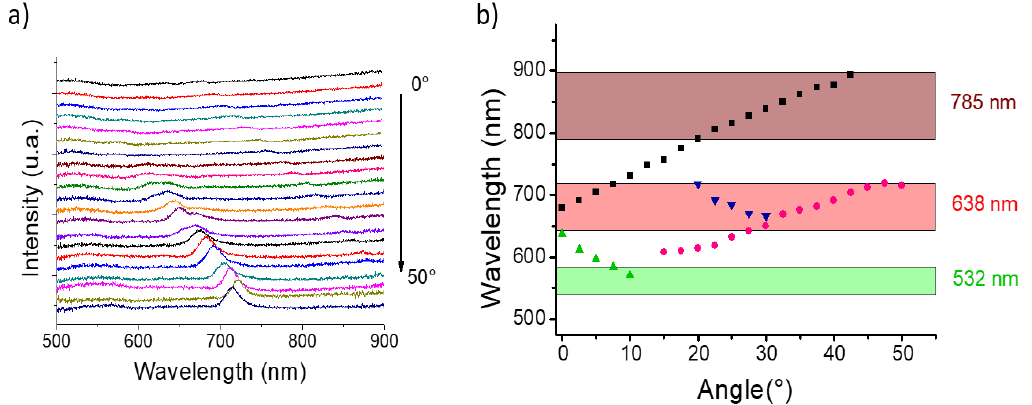
Figure 7. ( a ) Extinction spectra for our plasmonic substrate (nanocylinder diameter: 140 nm and thickness: 30 nm) depending on the incident angle (from 0 to 50 ◦ , step of 2.5 ◦ ). ( b ) Evolution of the position of the di ff erent plasmon bands depending on the incident angle (each symbol corresponds to the position of one band on the spectra shown in (a) and each color shows the evolution of one plasmon mode). The green, red and brown rectangles correspond to the spectral ranges between the excitation wavelength and the 1580 cm − 1 Raman band (532–581, 638–710, and 785–896 nm respectively). One can observe some modes splitting and some red or blue shifts with the angle (Figure